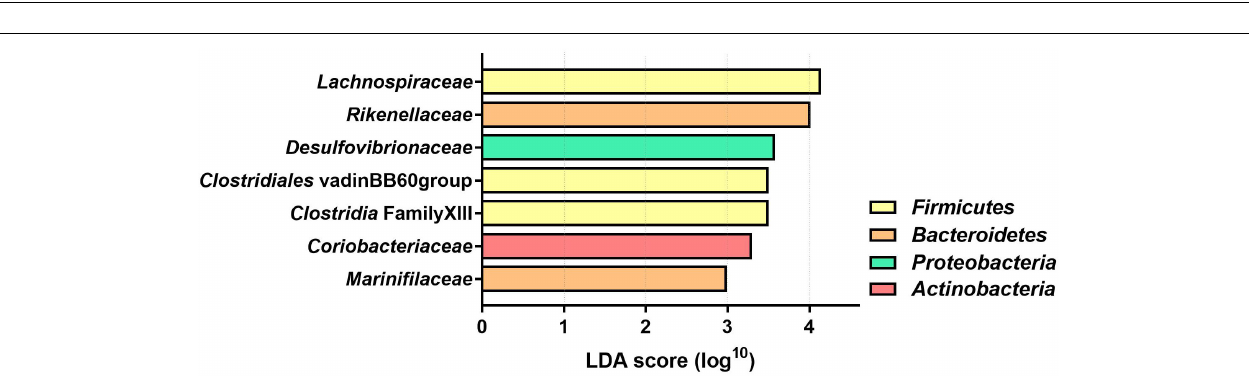
FIGURE 3 | PCA of Weighted Unifrac distances. Samples from each participant cluster closer together rather than separating into pre- and post-UVB exposure. The dotted ellipses are showing the ordination direction and clusters the samples of the VDS groups, post-UVB exposure.